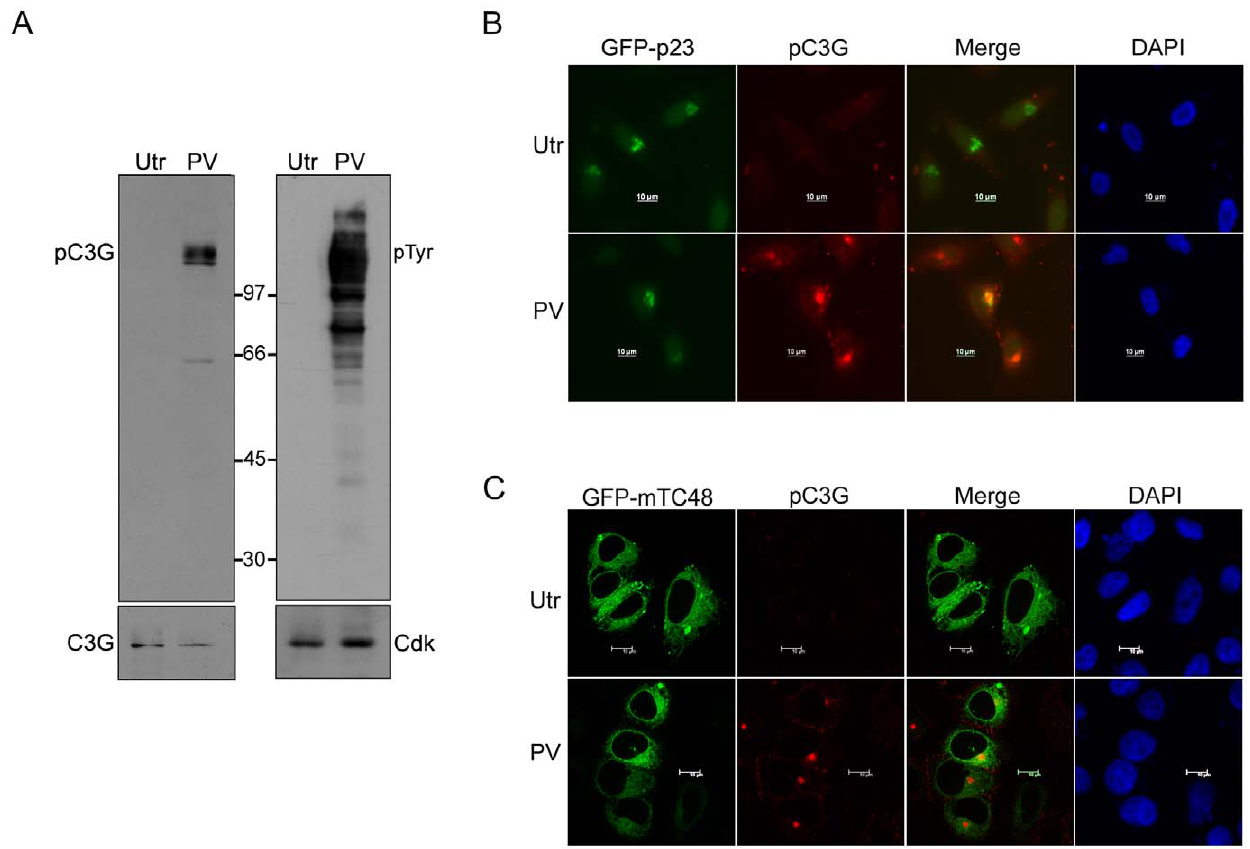
Figure 3. Pervanadate (PV) treatment induces Y504 phosphorylation of C3G and pC3G localizes to the Golgi. (A) IMR-32 cells were subjected to PV treatment and lysates used in Western blotting for pC3G, C3G, pTyr and Cdk2 (as loading control). (B) IMR-32 cells growing on coverslips were transfected with GFP-p23, subjected to PV treatment and stained for pC3G. Panels show images of cells captured using a fluorescence microscope fitted with an apotome. Bar, 10 m m. (C) pC3G co-localizes with TC48 at the Golgi. IMR-32 cells expressing GFP- mTC48 were subjected to PV treatment and stained for pC3G. Panels show a single section in the Z-axis captured using a confocal microscope. Utr, untreated, PV, pervanadate treated. Bar, 10 m m.